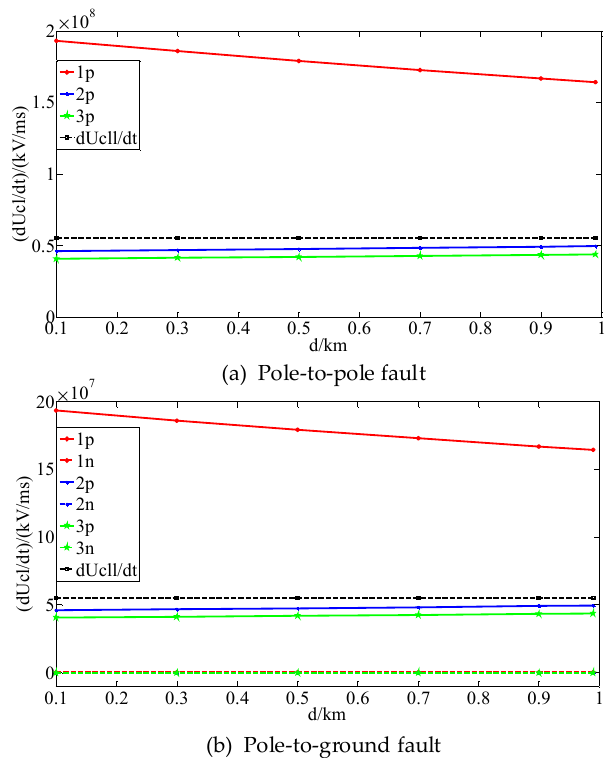
Figure 9. The Influence of Fault Location on the Voltage Change Rates of the CLIs.